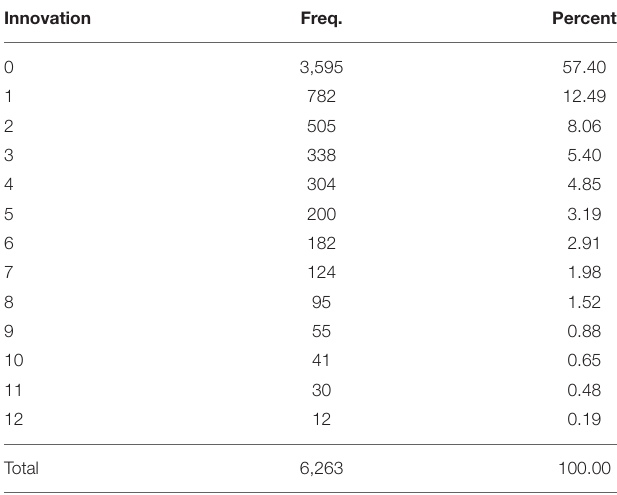
TABLE 3 | Innovation frequencies and percentages of food, beverage, and tobacco enterprises in EU (2012–2014). Innovation Freq.